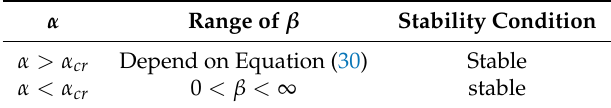
Table 1. The stability condition for the system under certain range of β